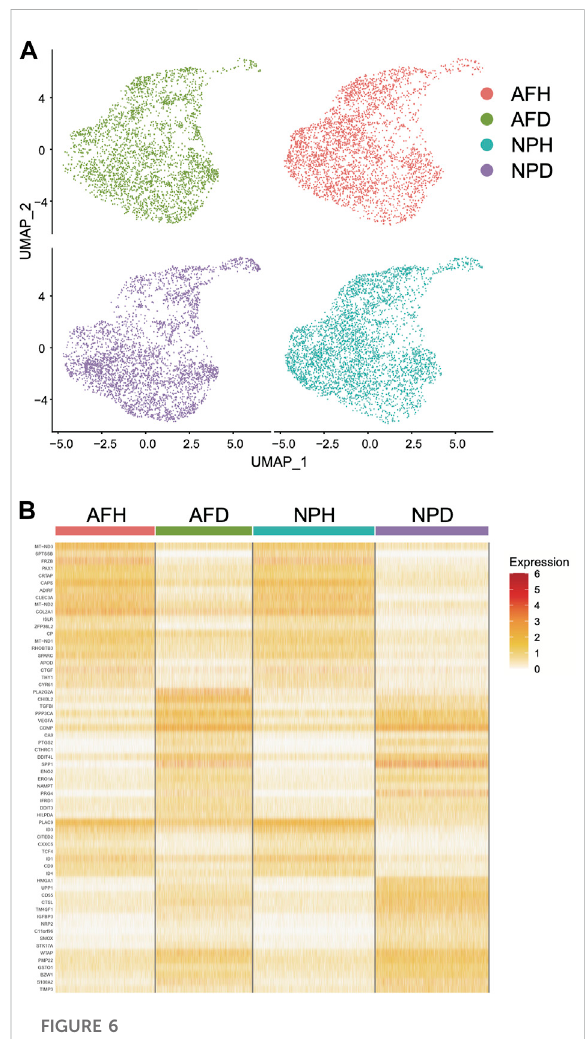
FIGURE 6 Single-celltranscriptomeanalysis. (A) Single-cellclusteringin the annulus fi brosus (AF) and nucleus pulposus (NP) of patients withintervertebraldiscdegeneration(IDD). (B) Heatmapofmarker gene expression in each cell group (top